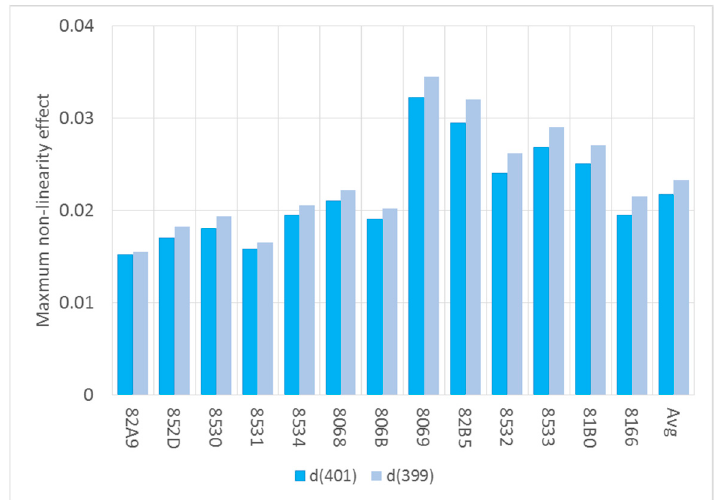
Figure 13. Maximum relative nonlinearity effect determined for 14 RAMSES sensors (both radiance and irradiance) from calibration spectra with FEL lamps 399 and 401.